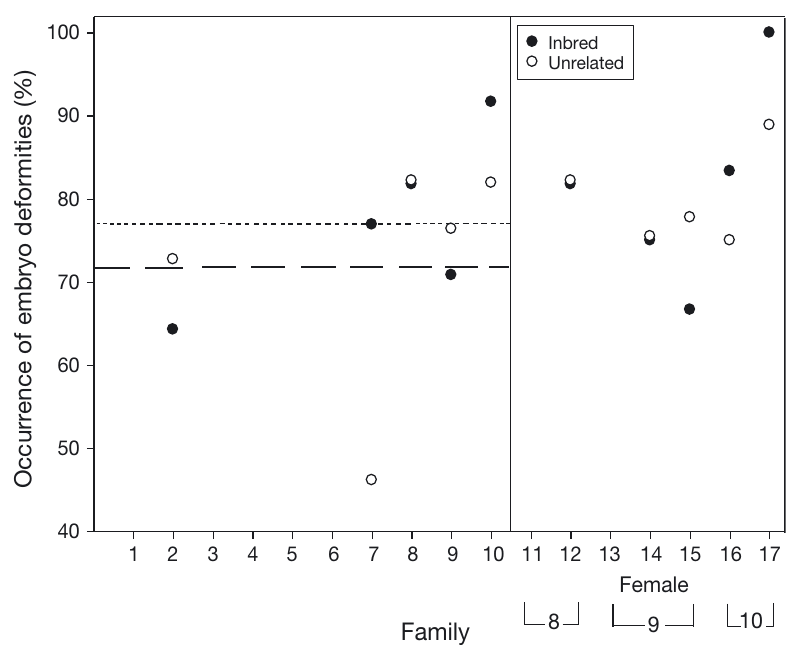
Fig. 2. Gadus morhua . Occurrence of embryo deformities (%) in the 7 crosses of inbred (filled circles) and unrelated (open circles) Atlantic cod that were photographed at the 4-cell stage. Five of the families (nos. 1, 3–6) and 1 fe- male within Families 8 and 9 could not be photographed at the 4-cell stage. Short dashed line: mean for inbred offspring; long dashed line: mean for un - related offspring. Families with >1 female are separated in the right panel